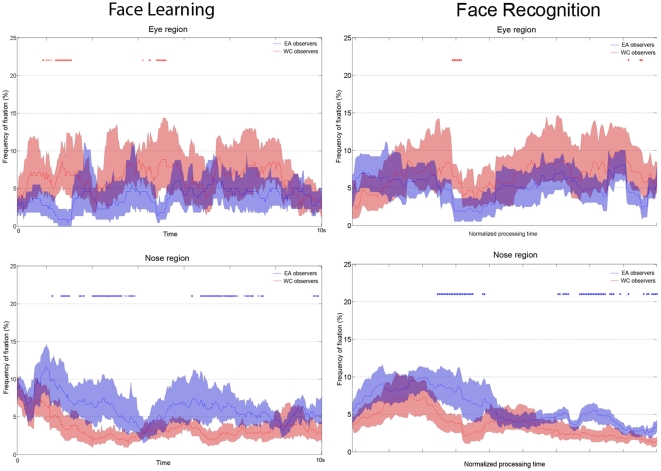
Time course of the frequency of fixations for the facial regions showing a cultural bias during face learning (left) and recognition (right).
Top: the eye region; bottom: the nose region. Note that since the response times varied across trials within- and between-observers, the time was normalized for this condition only. Observers from different culture showed a larger number of fixations towards their respective preferred regions throughout the entire time course. Significant differences at each time point across the two groups of observers are reported by an *. Shaded areas report the 95% confidence interval (Western Caucasian – red; East Asian – blue).